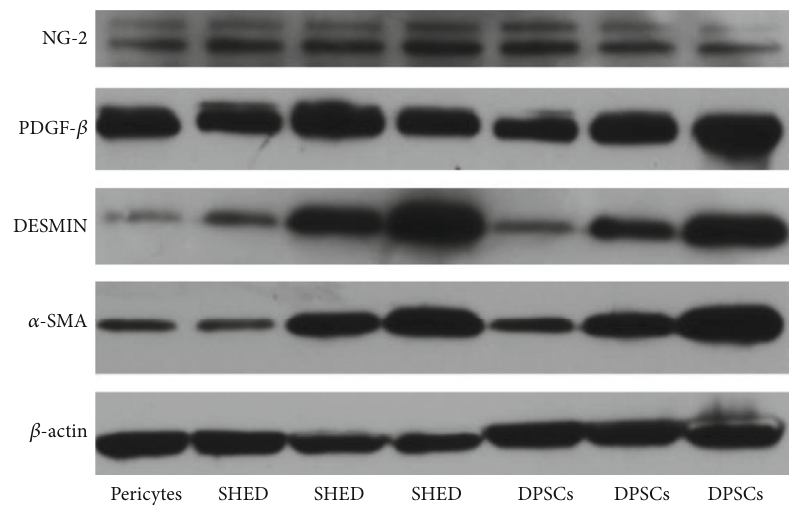
Figure 7: Real-time PCR results of (a) NG2, (b) α -SMA, (c) PDGFR- β , and (d) DESMIN mRNA expression levels in stem cells from human exfoliated deciduous teeth (SHEDs), postnatal human dental pulp stem cells (DPSCs), and pericytes after culture in Pericyte Medium (PM), α -Minimum Essential Medium (MEM), and Melanocyte Growth Medium (MGM) media for 14 d.